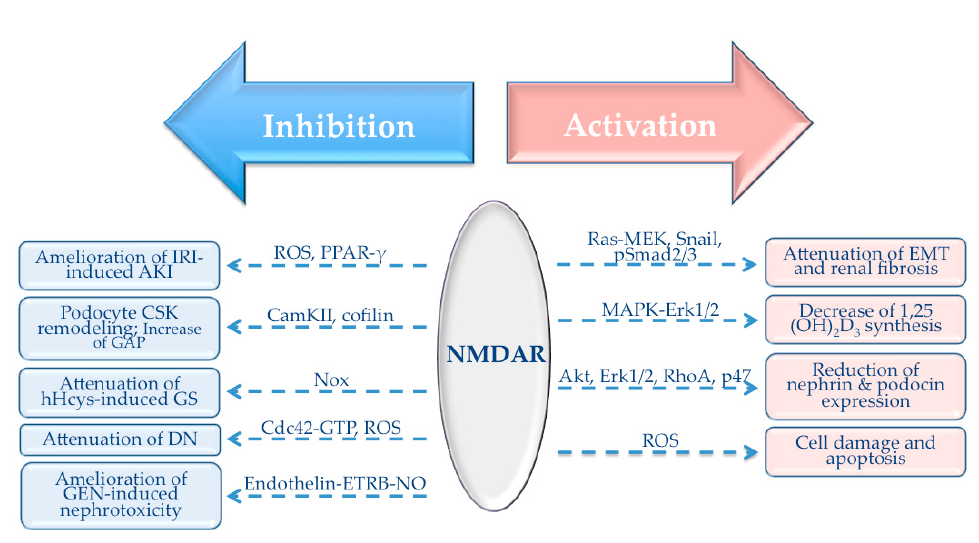
Figure 3. Signaling pathways involved in NMDAR-mediated responses in the kidney. AKI: acute kidney injury; CSK: cytoskeleton; GAP: glomerular albumin permeability; DN: diabetic nephropathy; GEN: gentamicin; EMT: epithelial–mesenchymal transition. Thick arrows refer to the mode of action of the NMDAR (red—activation; blue—inhibition). Intermittent arrows represent signaling pathways involved in a particular process or a disease where NMDAR is involved. For example, activation of NMDAR in the kidney leads to an attenuation of EMT and renal fibrosis with the involvement of Ras-MEK, Snail and pSmad2 / 3 pathways. On the other hand, inhibition of the NMDAR leads to an amelioration of IRI-induced AKI where ROS and PPAR- γ play a central role.